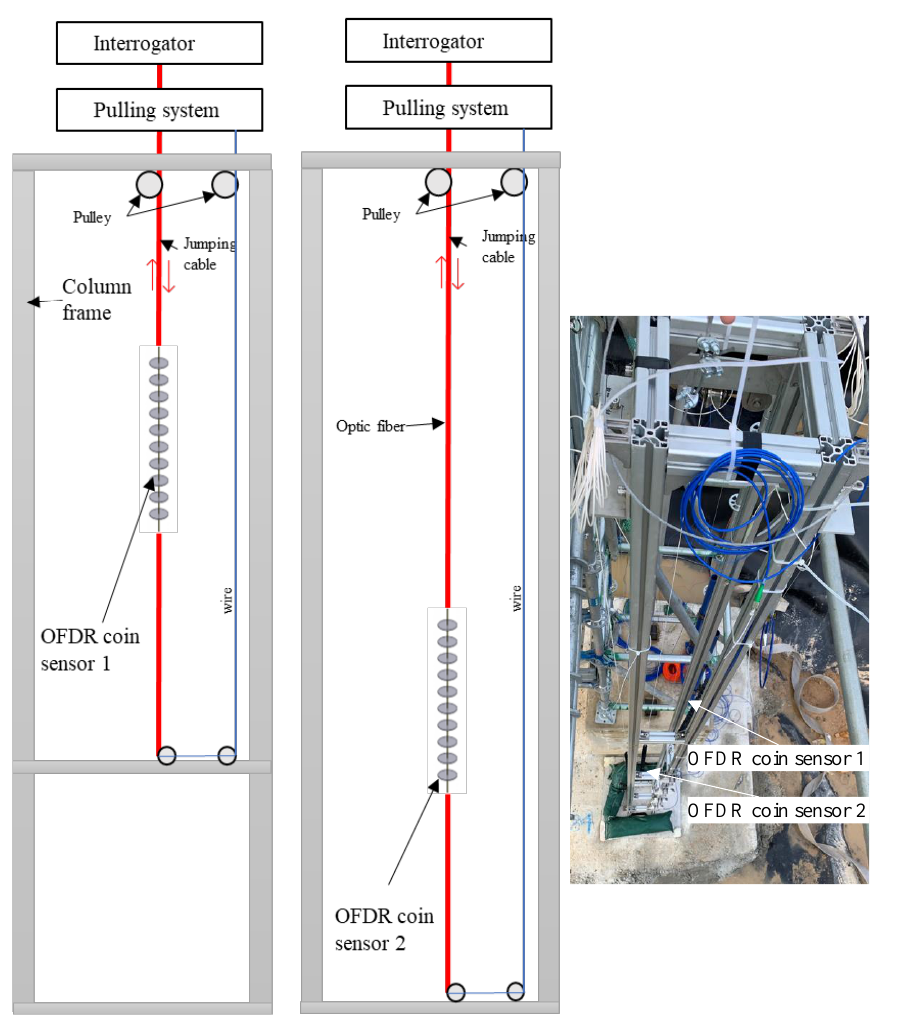
Figure 14. Application of OFDR coin sensor in a field trial.